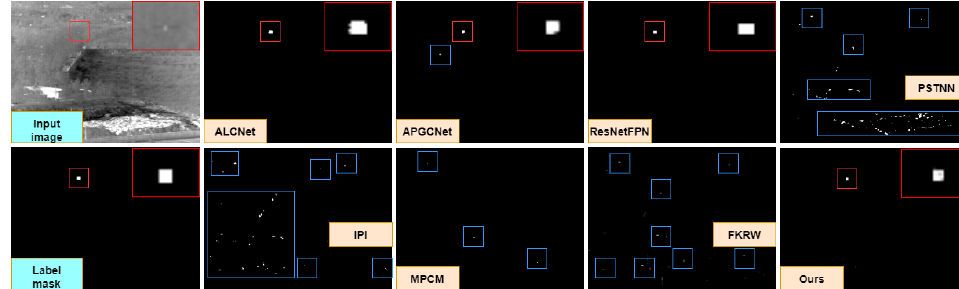
Figure 12. Detection results of infrared small targets in Scene 5 using different detection methods.